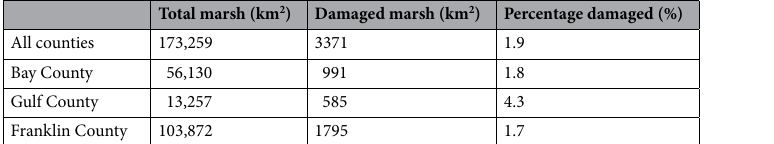
Table 1. Area of marsh damage by county.